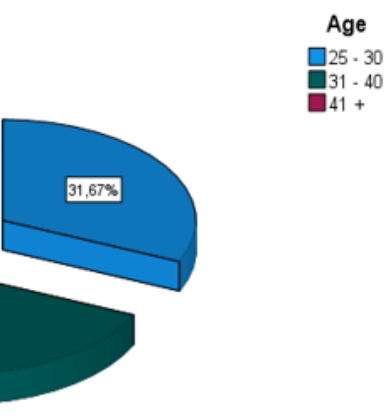
Figure 2. Pie chart presenting the respondents’ age